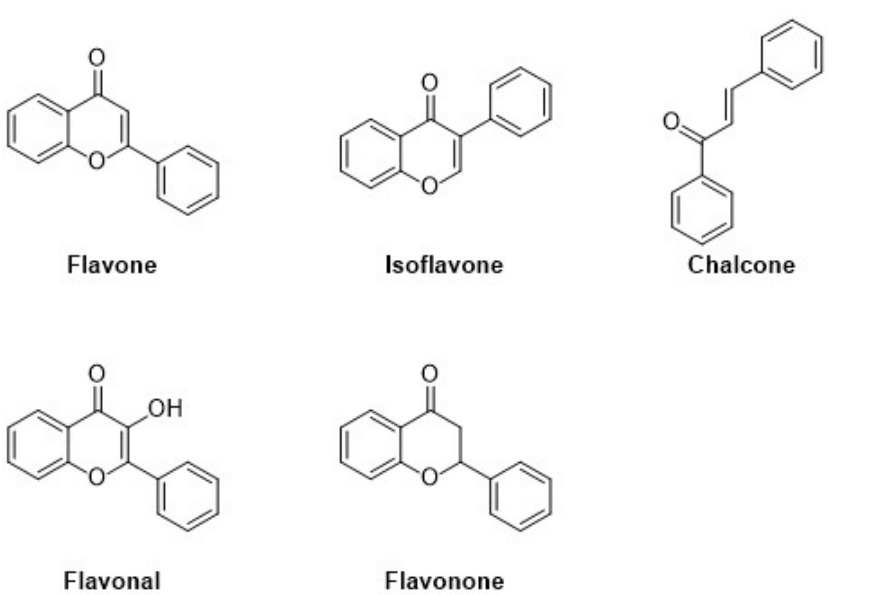
Figure 2. Classification and molecular structures with the examples of common plant-derived flavonoids.